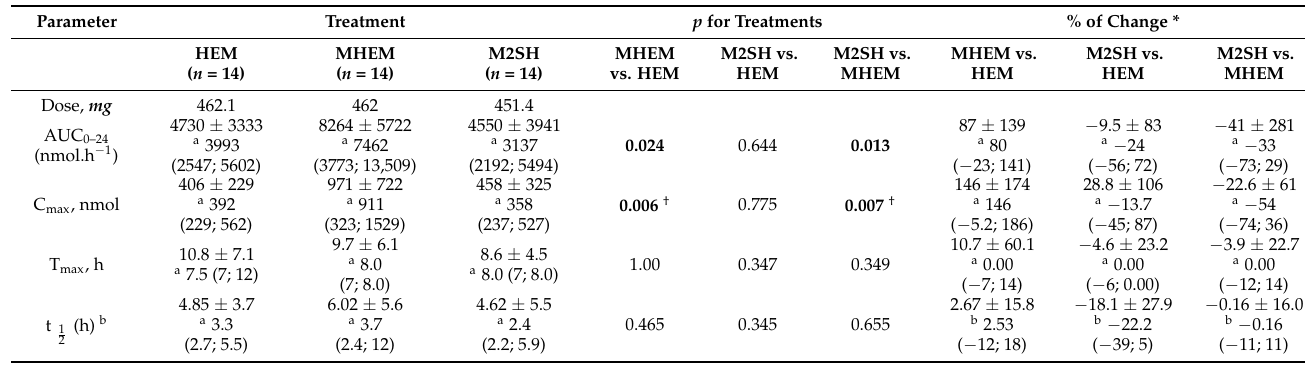
Table 4. Non-compartmental single-dose kinetics of Hesperidin metabolites after Hesperidin epimeric mixture (HEM), micronized Hesperidin epimeric mixture (MHEM) and micronized 2S-Hesperidin (M2SH)